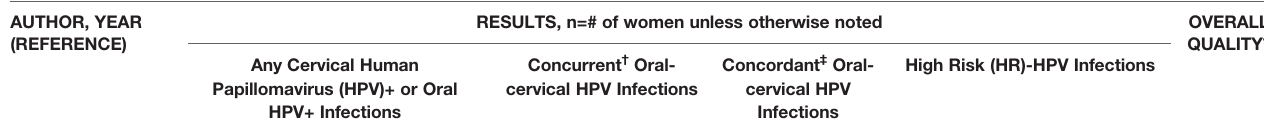
TABLE 3A | Results of the synchronous oral-cervical HPV evaluation papers